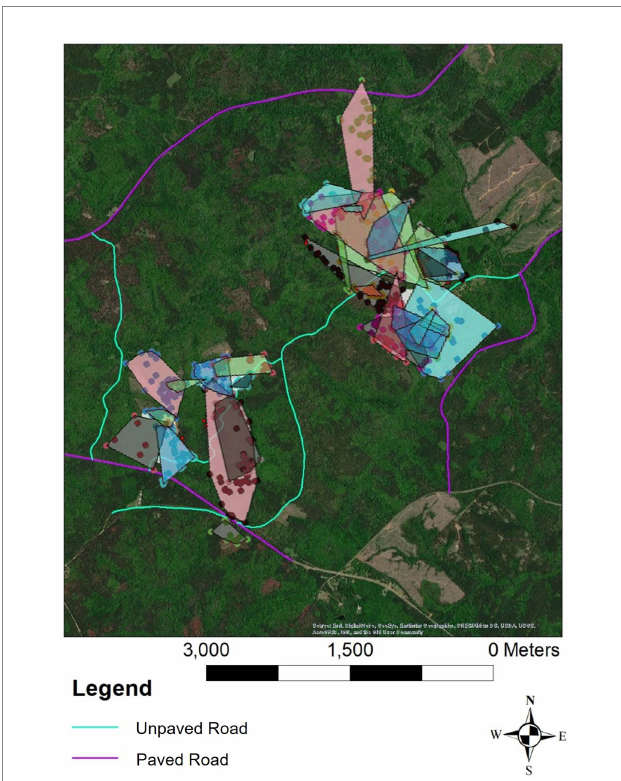
FIGURE 3 Map of the study site within Cedar Creek Wildlife Management Area in Putnam County, GA. Paved roads are outlined in purple, and unpaved, dirt roads are outlined in turquoise. Color coded points indicate the RT locations of each individual snake. 100% Minimum Convex Polygons depict home ranges for all individuals included in the study from 2020 to